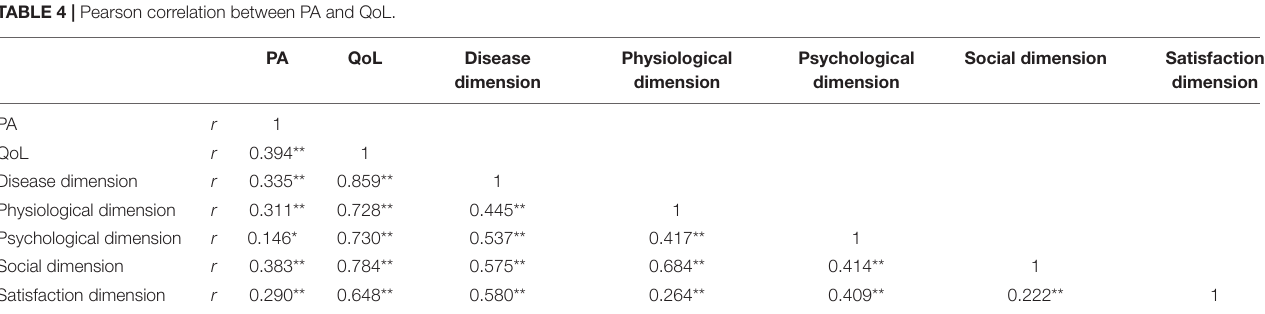
TABLE 4 | Pearson correlation between PA and